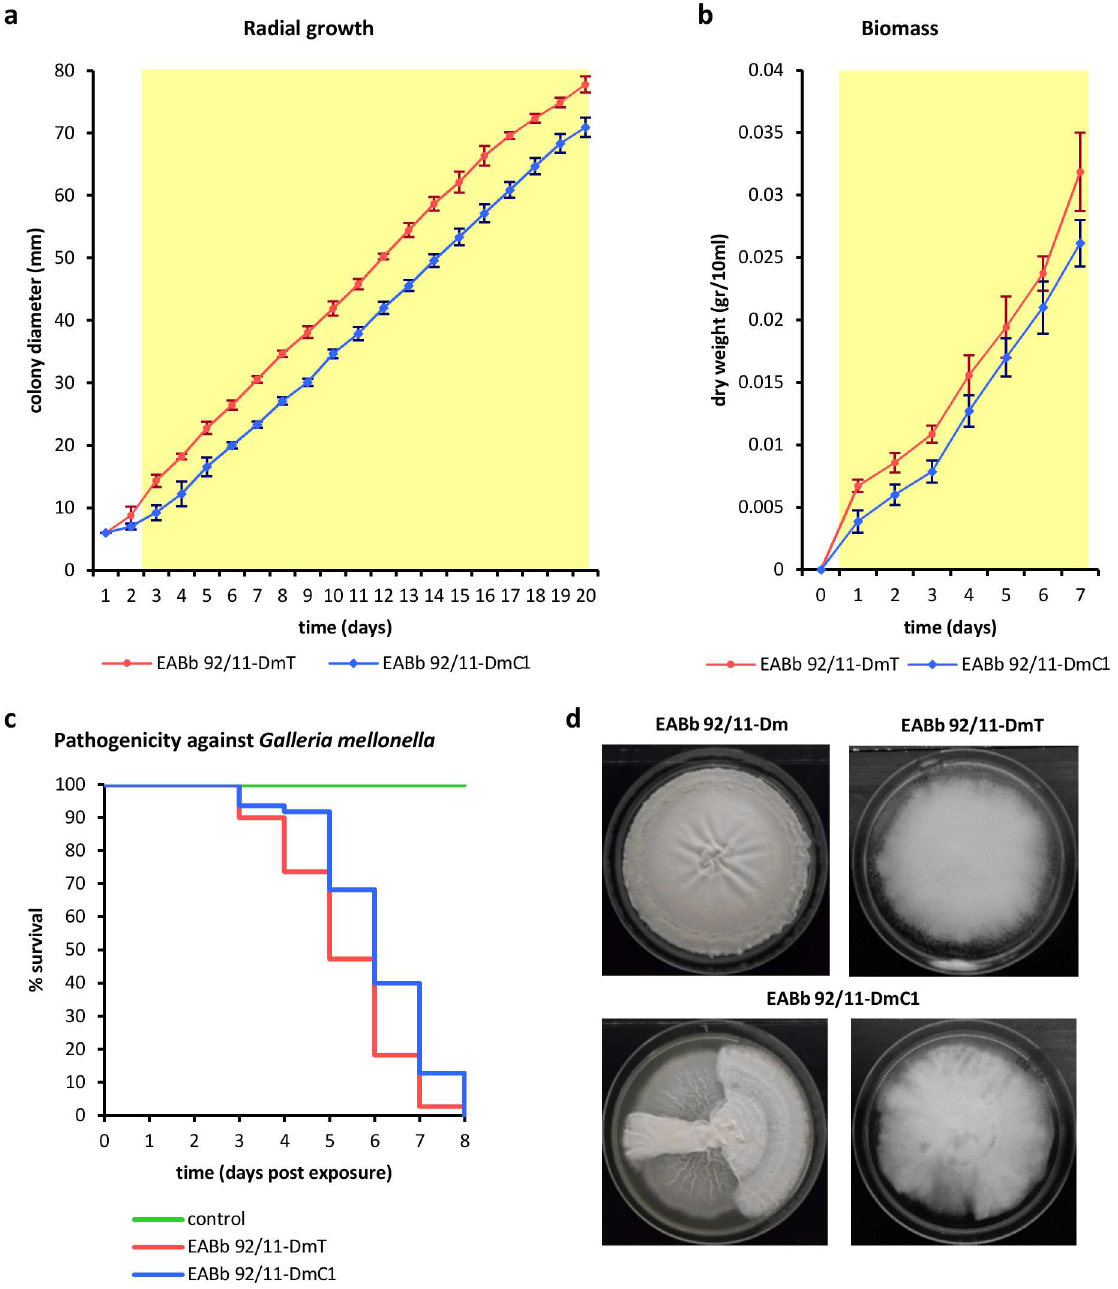
Fig 3. Comparison of the Beauveriabassiana EABb 92/11-DmT and EABb 92/11-DmC; virus-transfected and virus-free isogenic lines. Comparisonof the fungal growth in solid and liquidmedium; (a) radial growth and (b) biomass production of EABb 92/11-DmCand EABb 92/11-DmT. At least three independentrepetitionswere performed in triplicate (radial growth) or duplicate(biomass production)and error bars represent standarddeviation.A yellow background indicatesthe time points when the difference in growth is statistically significant(Student’s t test, P-value < 0.05). (c) Mean survival curves of G . mellonella larvae infected with the EABb 92/11-DmCand EABb 92/11-DmT isogeniclines. At least three independentrepetitionswere performed in triplicate. (d) Coloniesof the EABb 92/11-Dm, EABb 92/11-DmCand EABb 92/11-DmT grown on Czapek-Dox